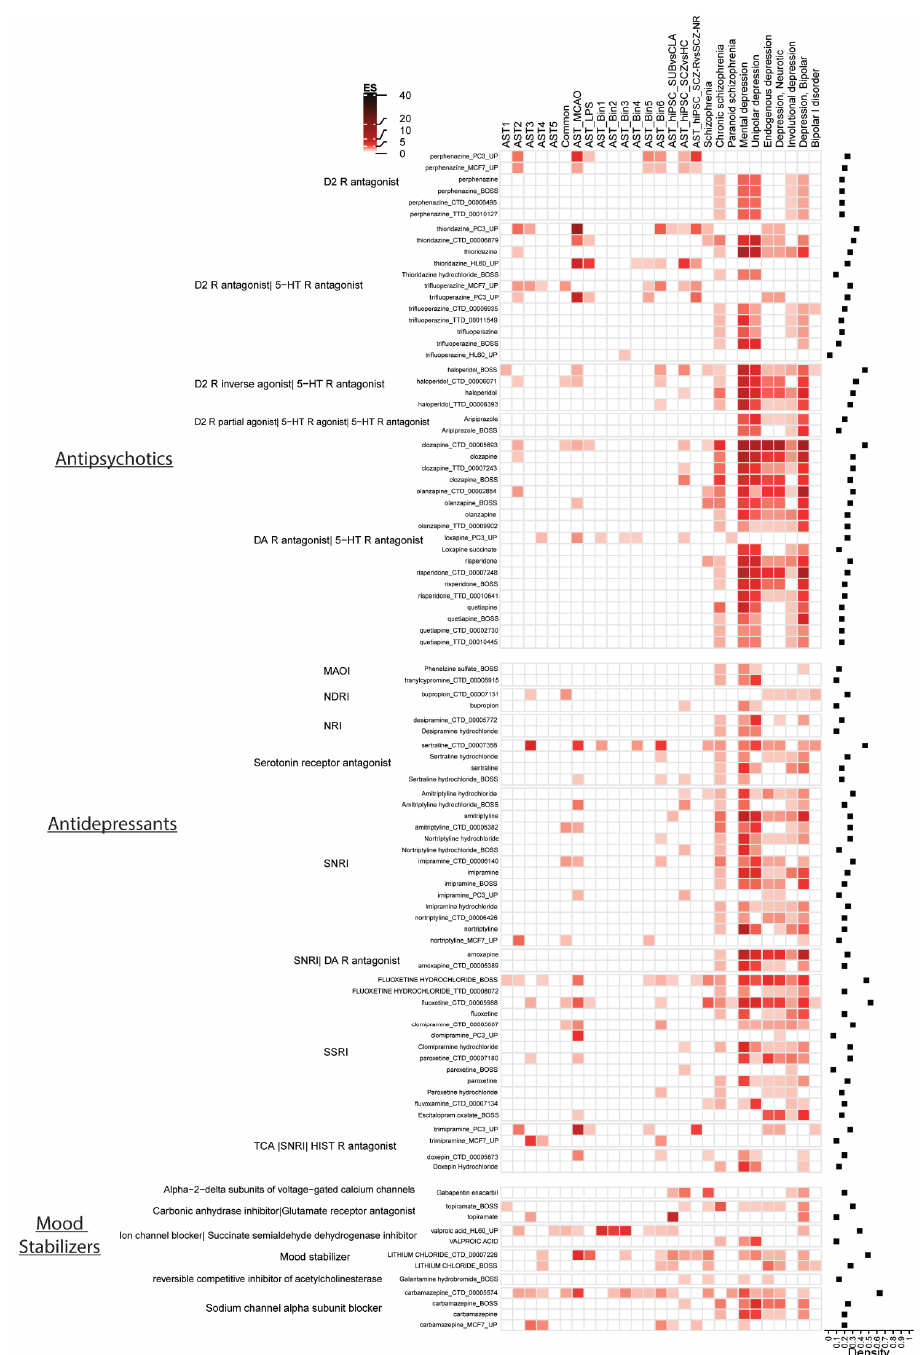
Figure 3. Gene enrichment of different classes of psychotropic medications across astrocyte gene-sets and neuropsychiatric and neurological disorders. Color intensity is proportional to -log10( p -value). Density index for all medications across astrocyte groups and disorders is displayed on right. AST astrocyte, CLA astrocyte classical subtype, ES enrichment score, HC healthy control, hiPSC human induced pluripotent stem cell, LPS lipopolysaccharide, MCAO middle cerebral arterial occlusion. SCZ schizophrenia, SCZ_R clozapine responder, SCZ_NR clozapine non-responder, SUB astrocyte